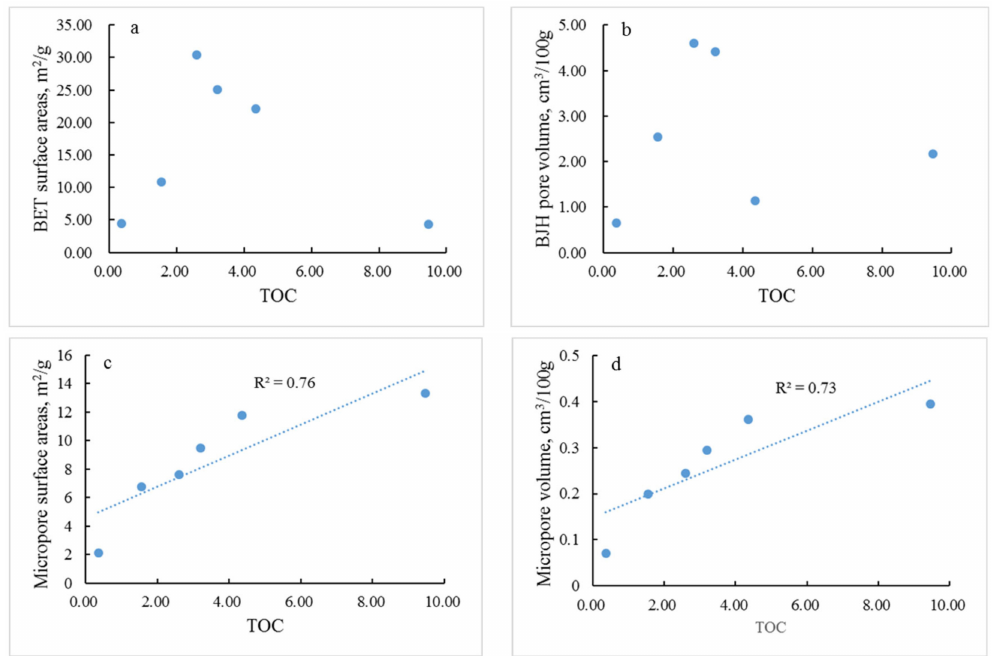
Figure 11. Mesopore surface areas and volume versus TOC content ( a , b ); micropore surface areas and volume versus TOC content ( c , d ) for siliceous shales.